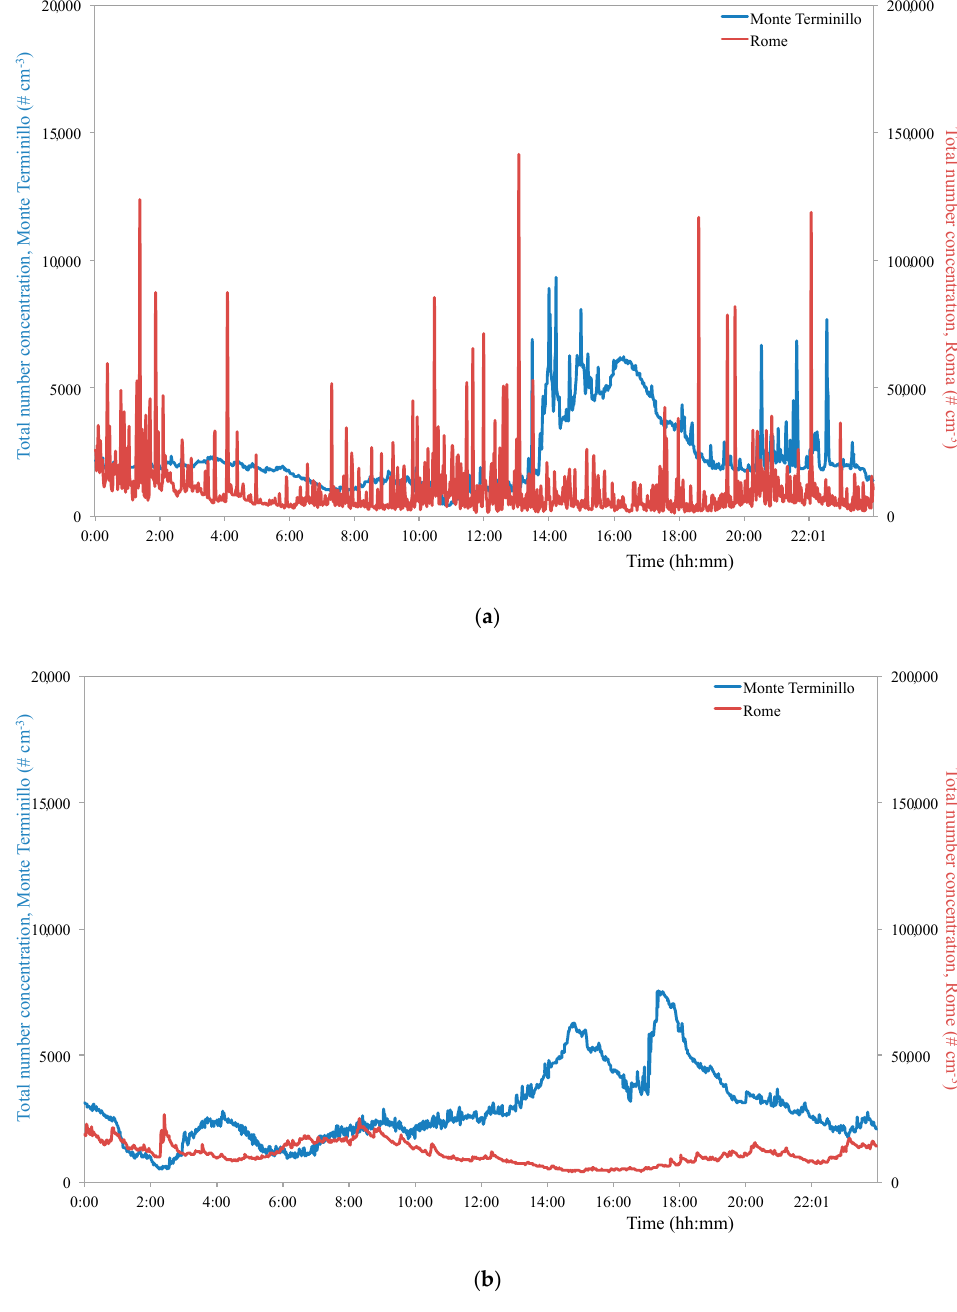
Figure 2. Typical number concentration daily trends recorded on workdays ( a ) and weekends ( b ) in the two sampling sites during the campaign.